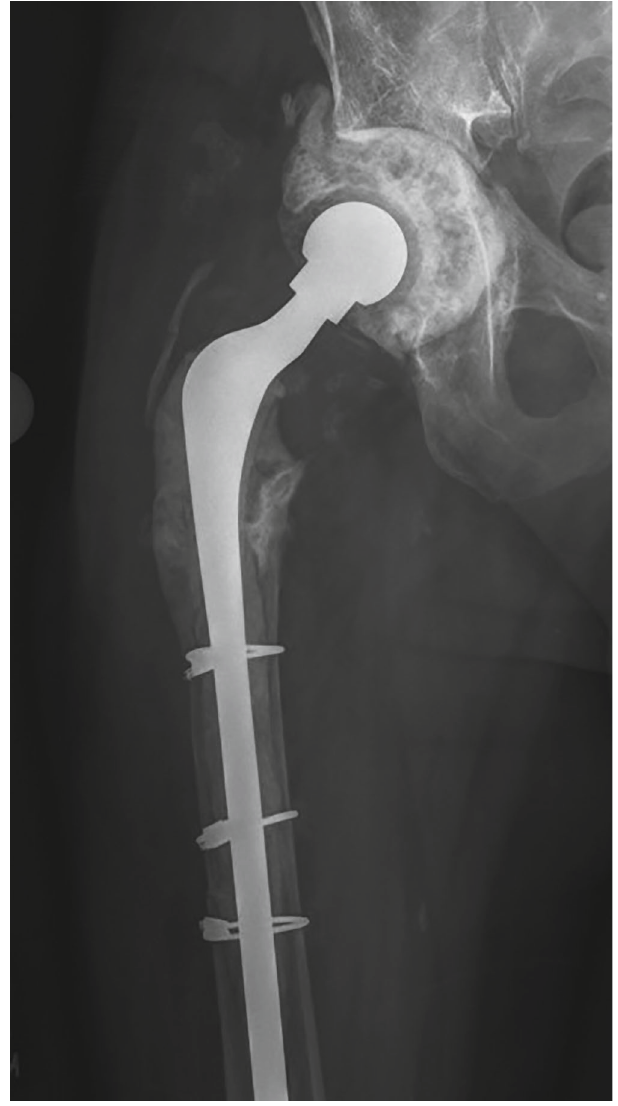
Figure 2: Anteroposterior X-ray of the right hip with antibiotic